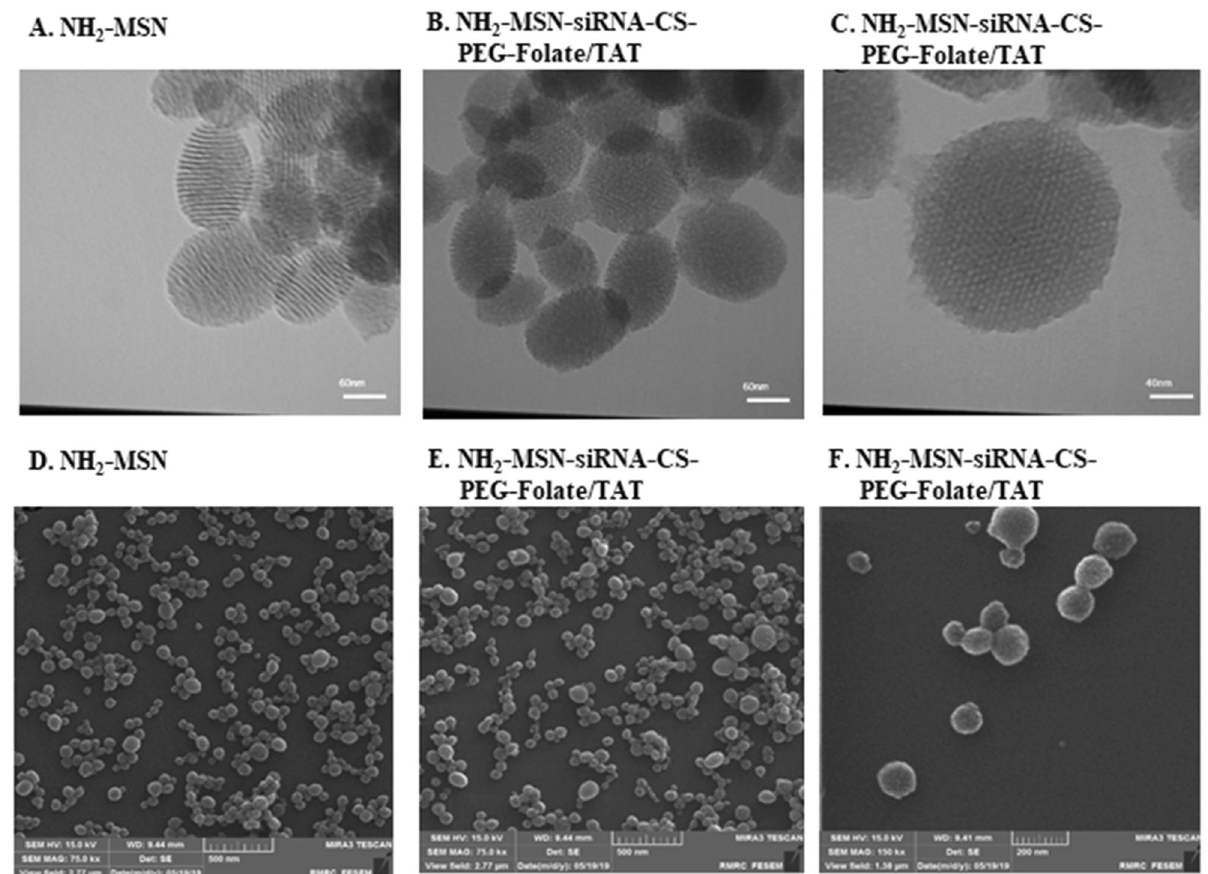
Figure 4. TEM and SEM images of the nanoparticles. NH 2 -MSNs at TEM and SEM monographs represent around 70 nm ( A , D ). NH 2 -MSN-siRNA particles coated with chitosan-PEG(3000)-folate/TAT were presented on TEM ( B , C ) and also on SEM images ( E , F ) with different zooming factors. The images represent homogenous particles around 100